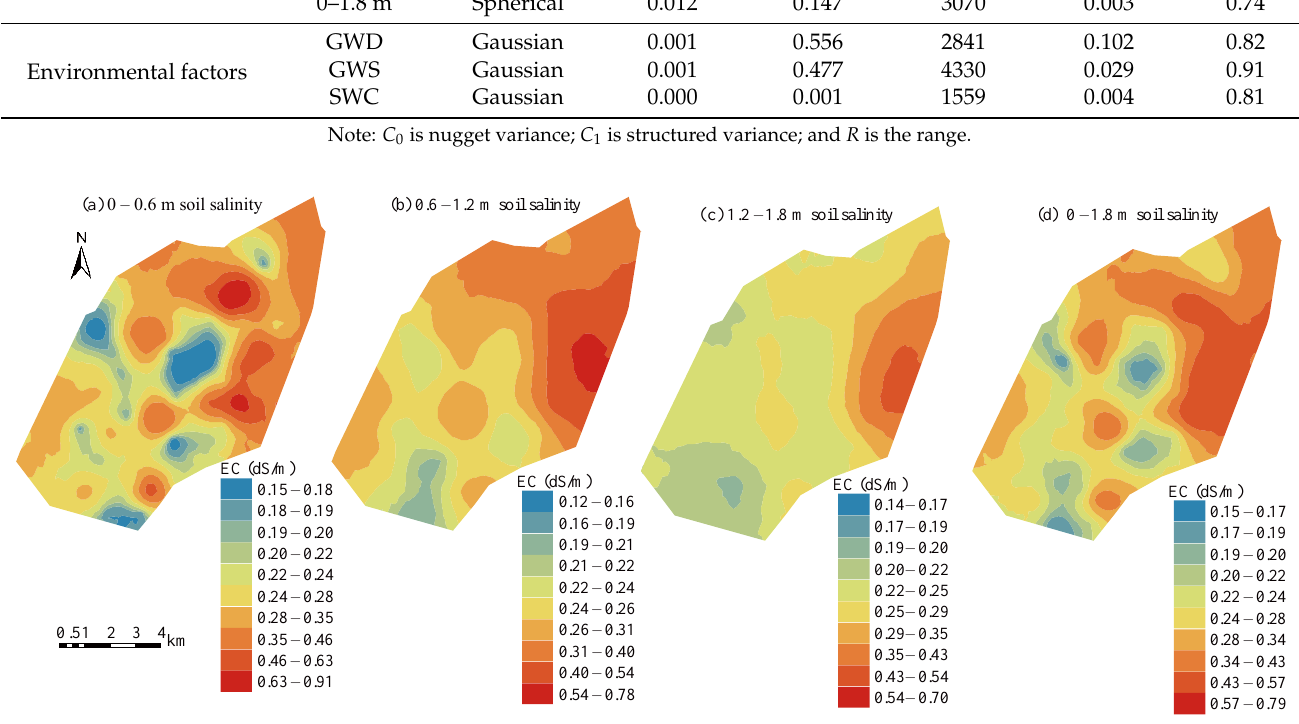
Figure 6. Spatial distribution of mean soil salinity over the four sampling times.